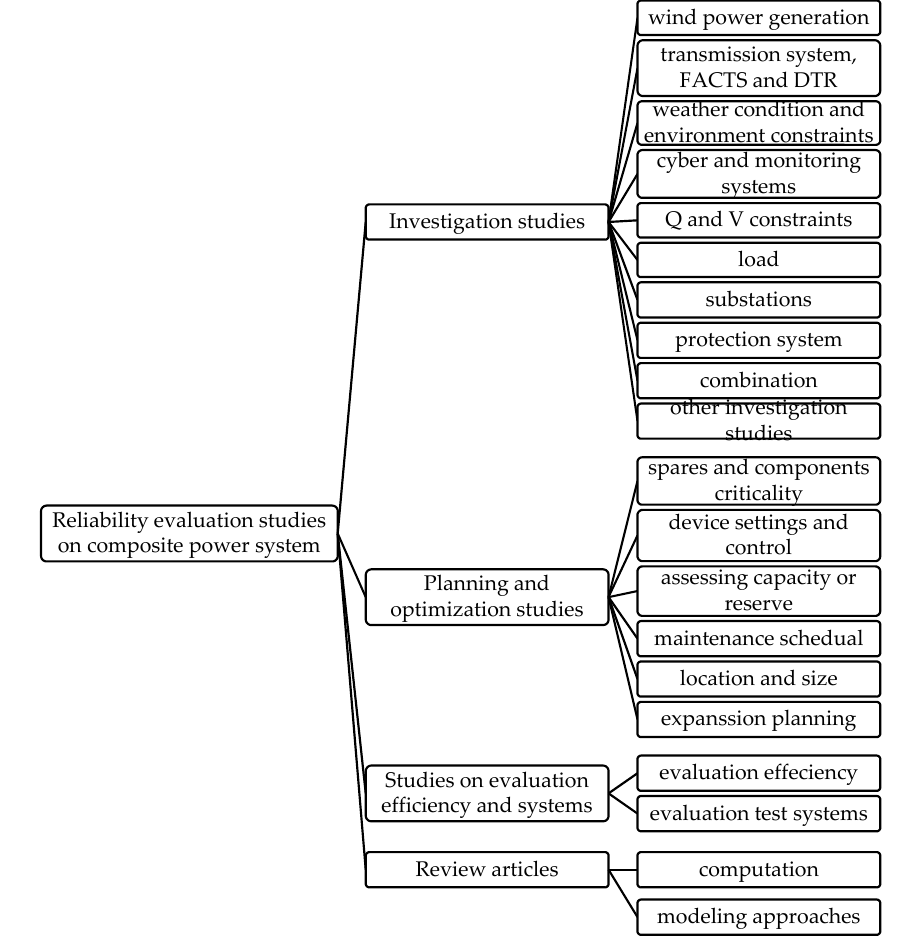
Figure 4. Taxonomy of reliability studies on composite power systems.